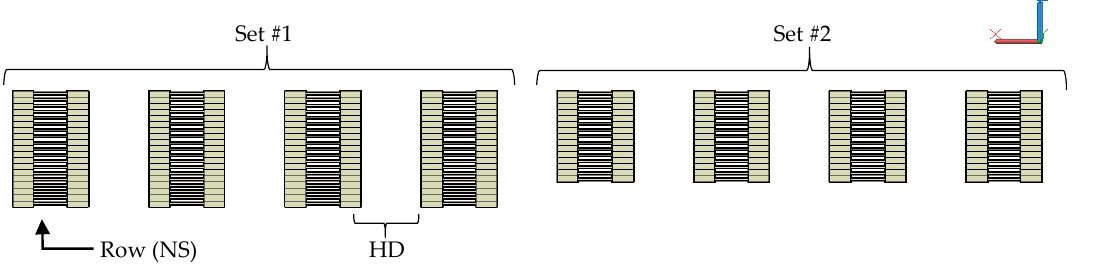
Figure 8. Definition of the parameters of variation in the arrangements of sleepers in the horizontal direction turned 90°: Sets, HD, and determination of rows.